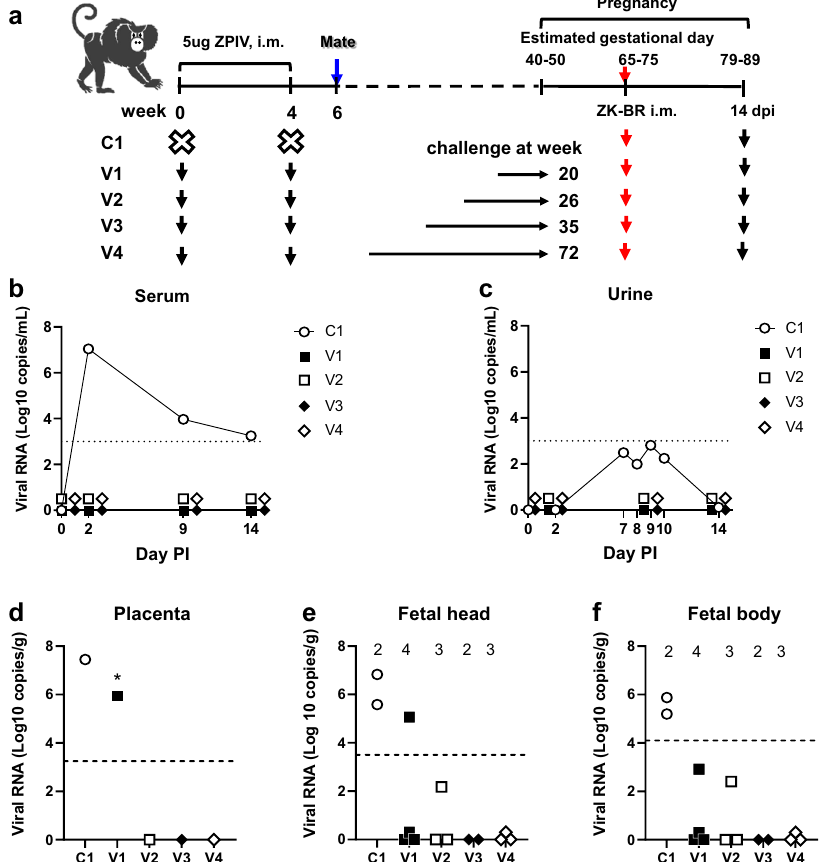
Fig. 3 ZPIV reduced viral RNA levels in fetal tissues in marmosets. The marmoset study scheme. Four marmosets, V1 – V4, were i.m. injected with two doses of 5 ug alum/ZPIV 4 weeks apart. After co-housing with males, pregnancy and estimated gestational day (EGD) were determined by ultrasound examination. Individual marmosets became pregnant at different times after vaccination. Time-lapse between the last dose of vaccine and the time of virus challenge is indicated as a dotted line in ( a ). Unvaccinated control C1 and vaccinated V1 – V4 marmosets were i.m. injected with two doses of 2.5 × 10 5 PFU ZK-BR 4 days apart during EGD 65 – 76 corresponding to 20, 24, 36, or 72 weeks after prime vaccination. Serum and urine samples were prepared at 0, 2, 9, and 14 days after infection (dpi) and viral RNA loads were determined in serum ( b ) and urine ( c ) using Real-Time qRT-PCR. All marmosets were sacri fi ced for examination at 14 dpi (EGD 79 – 89) and viral RNA levels in the placenta ( d ), fetal head ( e ), and fetal body ( f ) were determined. Three different locations in the placenta were sampled. RNA from each placental sample was prepared independently, and each sample was tested in duplicate. The asterisk indicates that one out of three locations in the placenta was positive for viral RNA (2.7 × 10 7 copy/g tissue) while the other two sites were negative for viral RNA. The mean of the three locations is presented. The number of fetuses per pregnant marmoset at each time point is indicated above the symbols in ( e ) and ( f ). The horizontal dotted lines indicate the limit of quanti fi cation per tissue, as described in Materials and insuf fi ciency 23 . Despite this, the fetal demise induced by ZIKV infection was dose-dependent. Therefore, this pregnant mouse model offered an initial, experimentally amenable, testing plat- form to evaluate the ability of vaccines to prevent ZIKV-associated fetal demise and malformations. We also previously reported that ZIKV infection during marmoset pregnancy caused spontaneous fetal abortion associated with vertical transmission of virus 32 . This provided a second, more physiologically relevant, NHP pregnancy model to test vaccine ef fi cacy. In the current study, both prime and prime-boost vaccination of ZPIV provided 80% ef fi cacy in protection against fetal malforma- tions after ZIKV infection during pregnancy in C57BL/6 mice. Previously, an intramuscular (i.m.) injection of a single dose of ZPIV was shown to provide complete prevention of viral infection in non-pregnant Balb/C mice 17 . Different study conditions between the current and previous studies may stem from several factors: (1) differing susceptibility to infection and pathogenicity of different mouse strains, (2) the higher viral dose (5 × 10 5 PFU) used for PFU) 17 , (3) different quantities of neutralizing antibodies might be